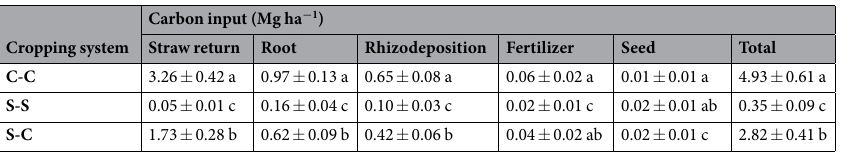
Cropping system